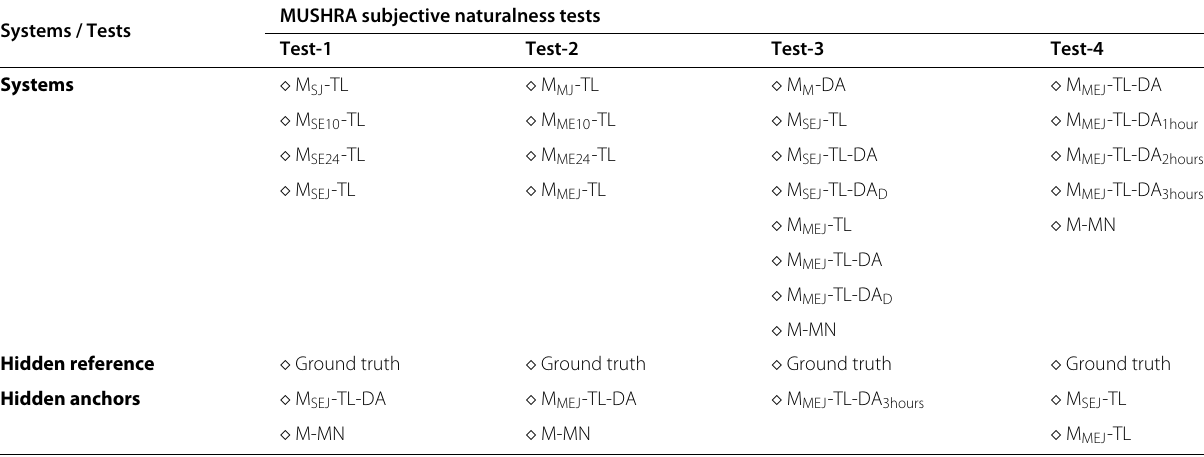
and Test-4, shown in Table 4), each containing eight stim- ulus panels. Each panel included a hidden reference and hidden anchors. In addition to the hidden reference and hidden anchors, Table 4 also shows all the systems that generated the speech samples included in each